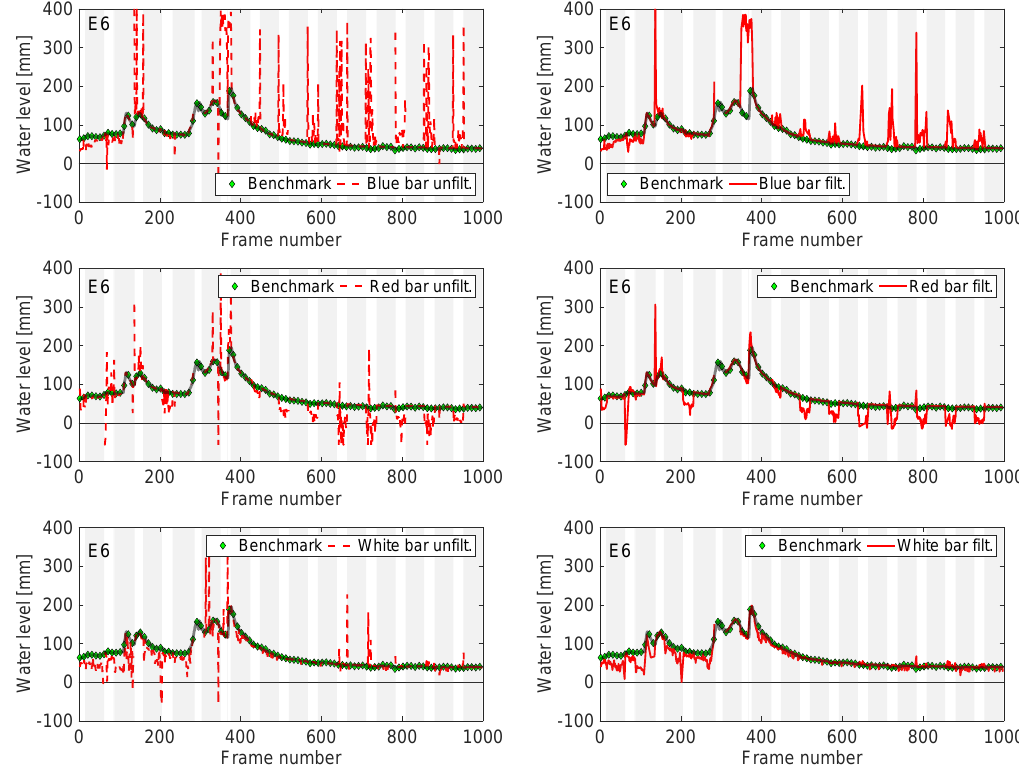
Figure 8. Raw ( left ) and filtered ( right ) water levels computed from the bars ( top : blue, middle : red, bottom : white) for experimental test E6. Benchmark water levels are in green markers and transparent black; bar raw and filtered in dashed and solid red, respectively. Light gray vertical bars indicate NIR frames. Images are treated with the large image